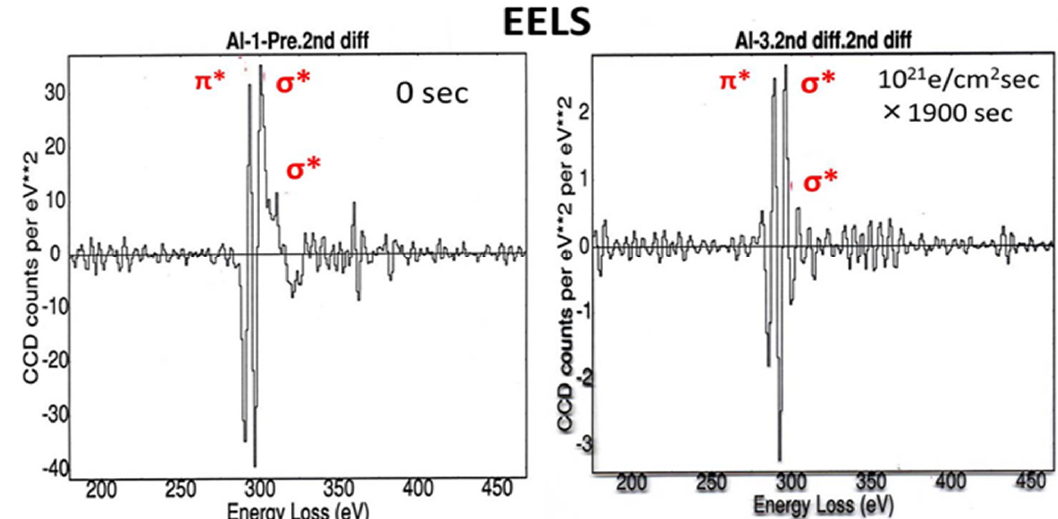
Figure 15. Second derivative of the EELS of the intercalated structure formed under electron irradiation of 1.0 × 10 21 e/cm 2 s for 1900 s. No change is observed in the π -bond between layers after irradiation, whereas the σ -bond, sp 2 in-plane, decreased, which suggests the Al and Cu intercalated atoms partially replaced the carbon atoms [12].